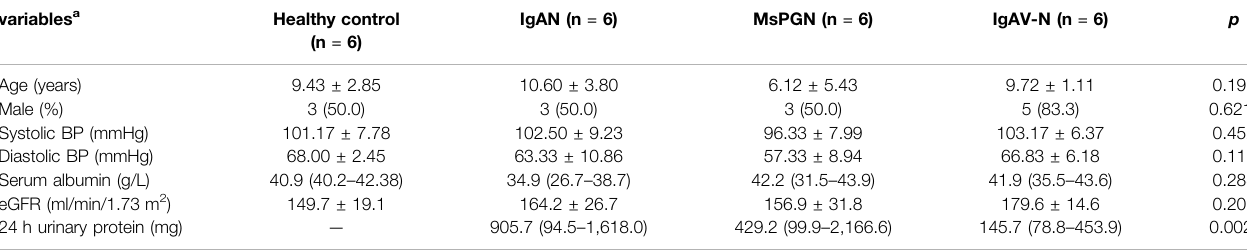
TABLE 1 | Demographic and clinical features of the healthy control group, and patients with IgAN, MsPGN, and IgAV-N. variables